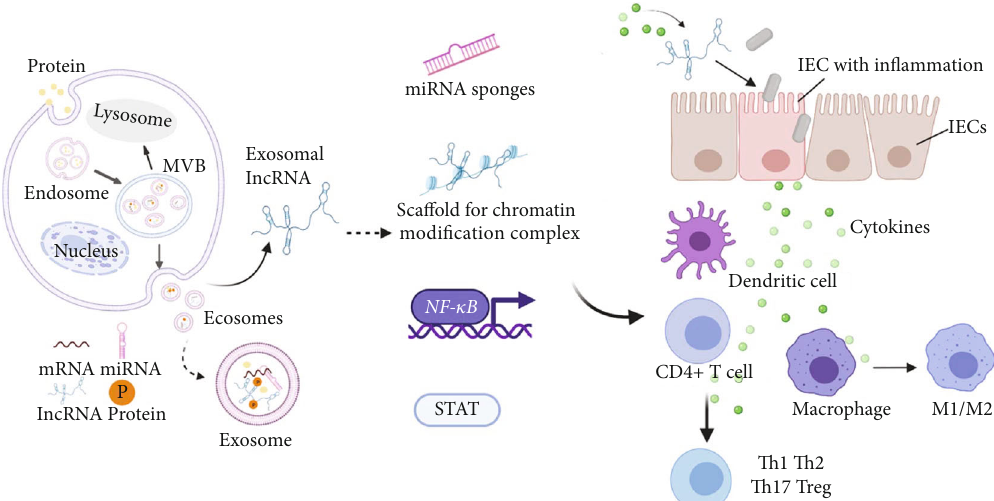
Figure 2: Formation of exosomes and mechanisms of exosomal lncRNA in the intestinal mucosal immune barrier. The formation of the exosome begins at endosomes formation and then maturates to multivesicular bodies (MVBs). MVBs either fuse with lysosomes and are degraded or fuse with the plasma membrane resulting in the release of free exosomes to the extracellular environment. Exosomes may contain various cargoes including proteins, mRNAs, lncRNAs, and miRNAs. Exosomal lncRNAs participate in the intestinal mucosal immune response by in fl uencing the activity of transcription factors or acting as sca ff olds for chromatin modi fi cation complex, miRNA sponges, translation inhibitors, or mRNA degradation signals. This leads to the regulation of various biological events including the integrity of IECs, polarization of macrophages, di ff erentiation of CD4 + T cells, and some in fl ammatory signaling